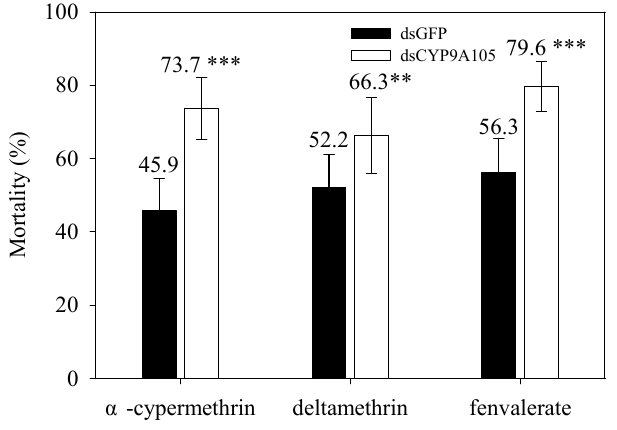
deltamethrin, α -cypermethrin or fenvalerate resulted in higher mortality than was observed for larvae exposed to these insecticides in the absence of dsCYP9A105 injections. Taken together, our results strongly suggest that CYP9A105 might play a role in the detoxification of pyrethroid